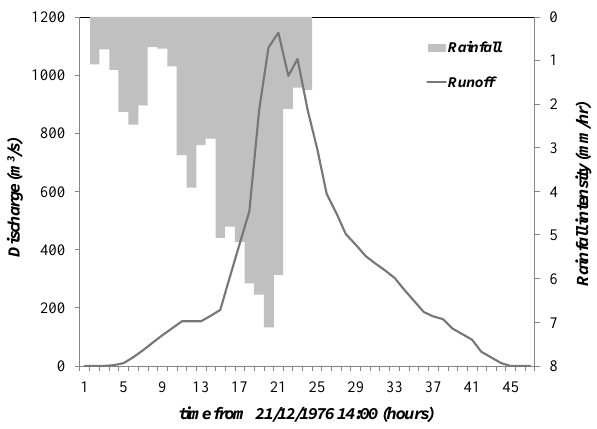
Figure 8. Event of 21 December 1976 registered at the Drasi flow- gauge.